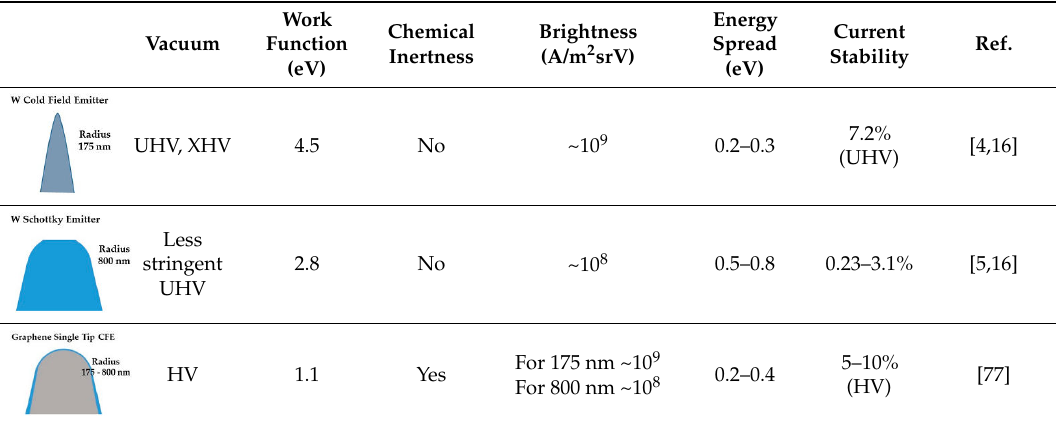
Table 1. Comparison of typical operating parameters and electron optical properties for the graphene coated point cathode and the state-of-the-art electron